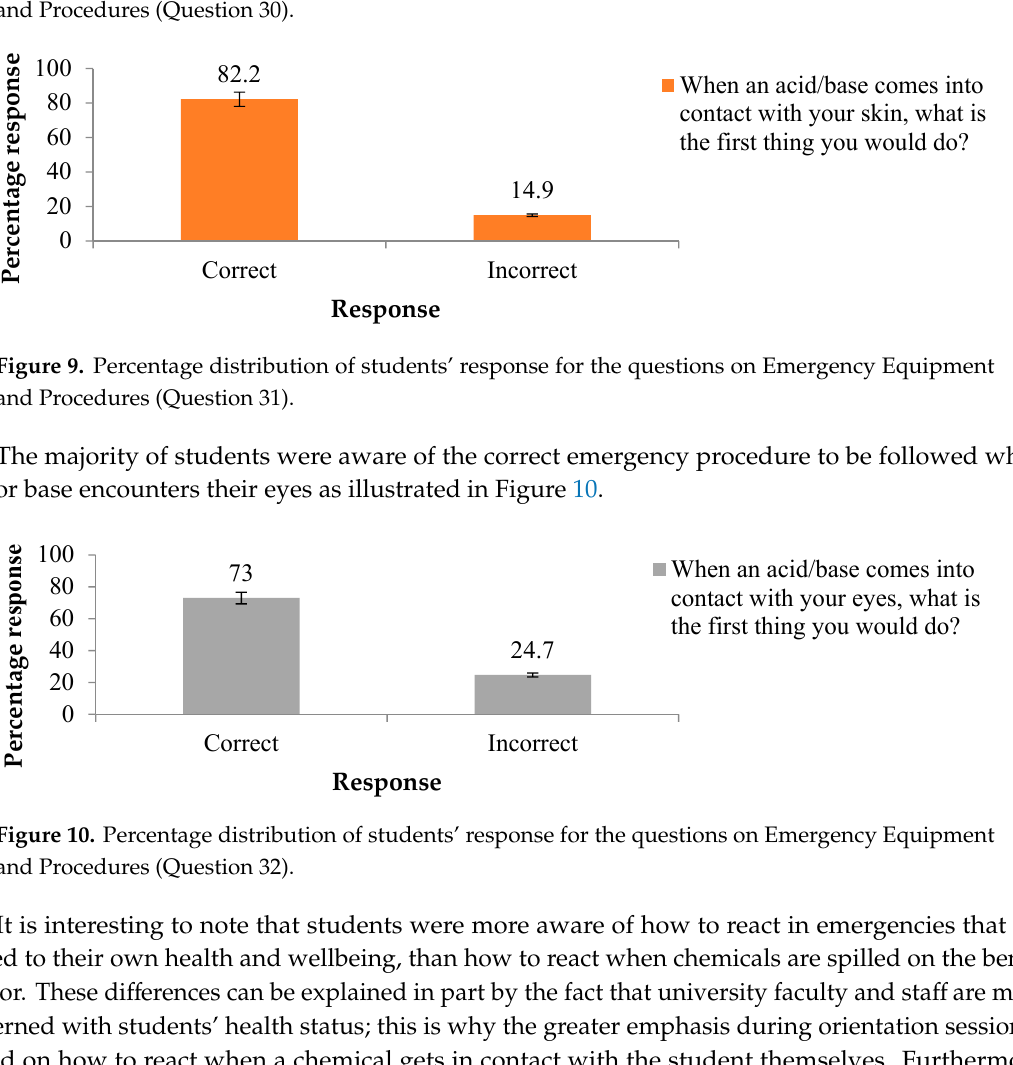
Table 5. Frequency distribution of supervisors by selected demographics.